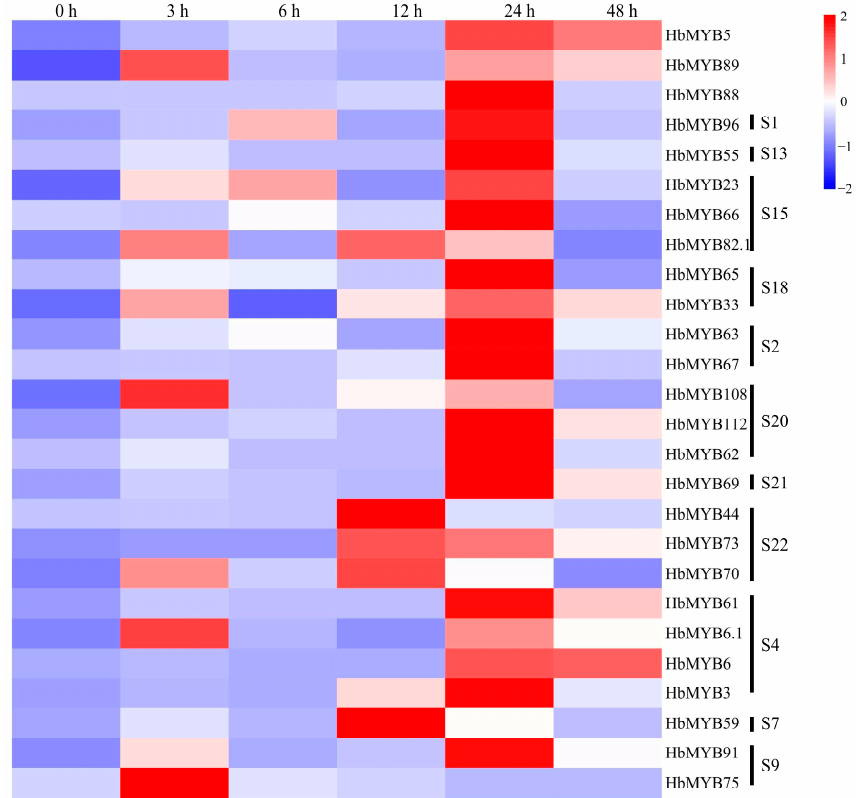
Figure 6. Expression analysis of HbR2R3-MYBs in rubber trees subjected to powdery mildew infection.